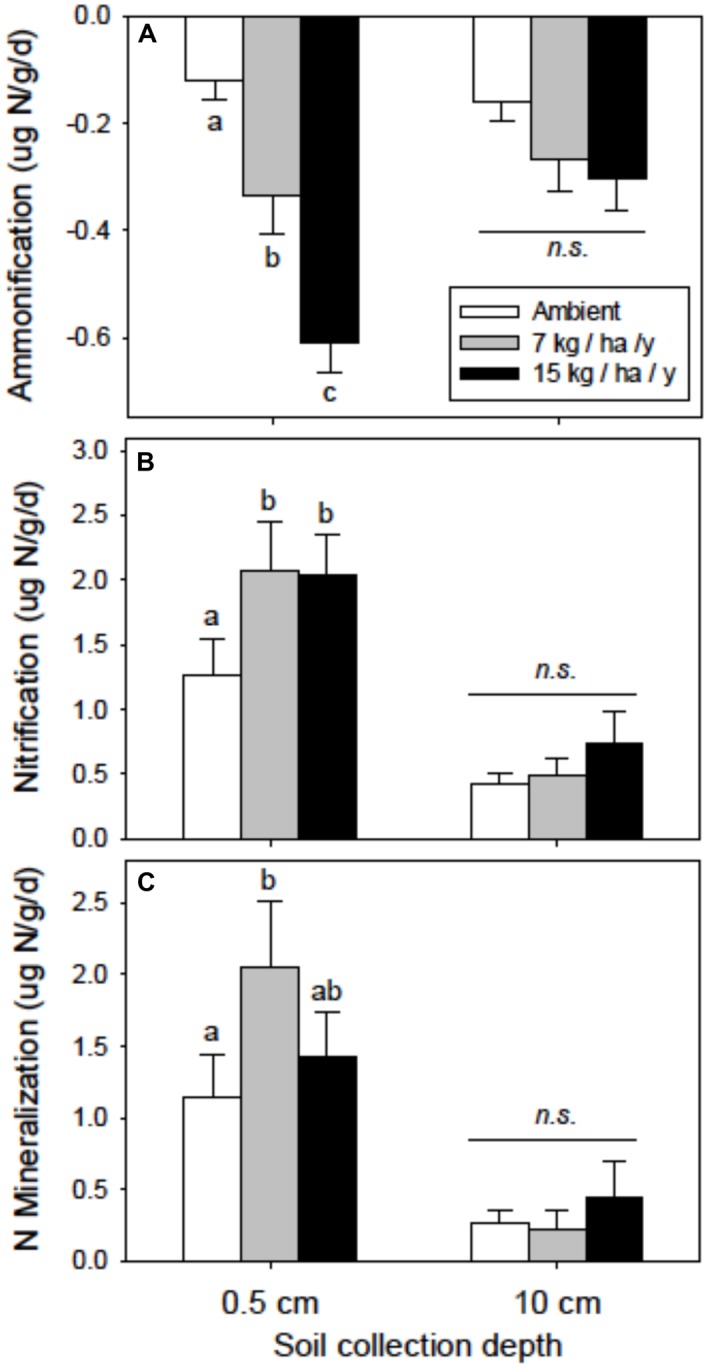
N transformation rates in relation to experimental N addition for biocrust (0.5 cm) and soil (0–10 cm). (A) Ammonification. (B) Nitrification. (C) N mineralization. Different letters indicate significant differences among the N treatments. Data summarized in Table 2. Statistical results presented in Supplementary Table S2.